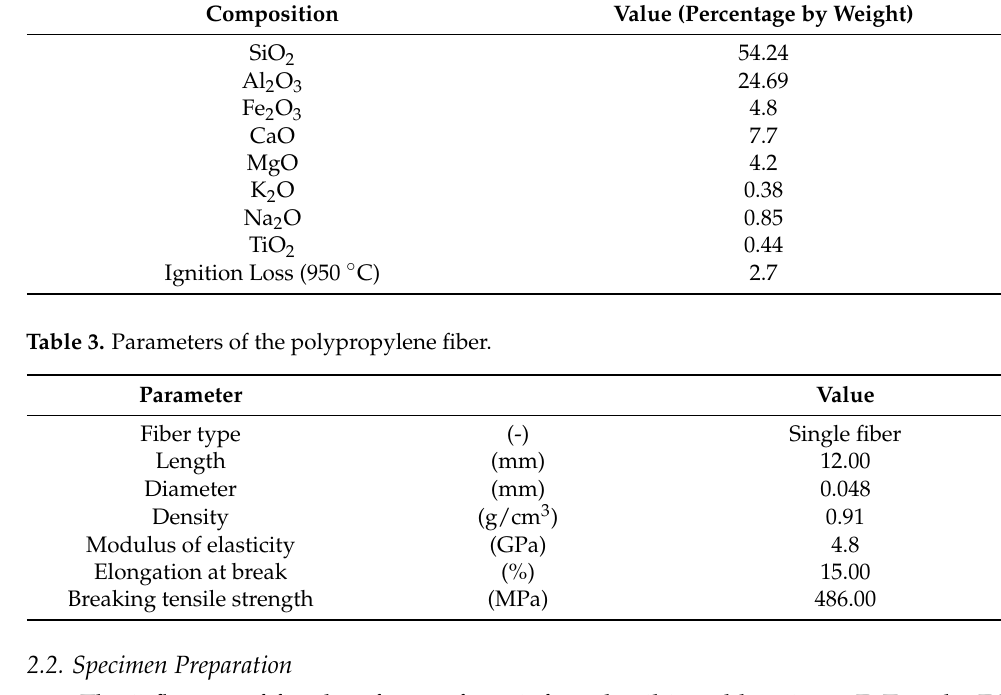
Figure 1. Particle size distribution curve of the loess and fly ash.